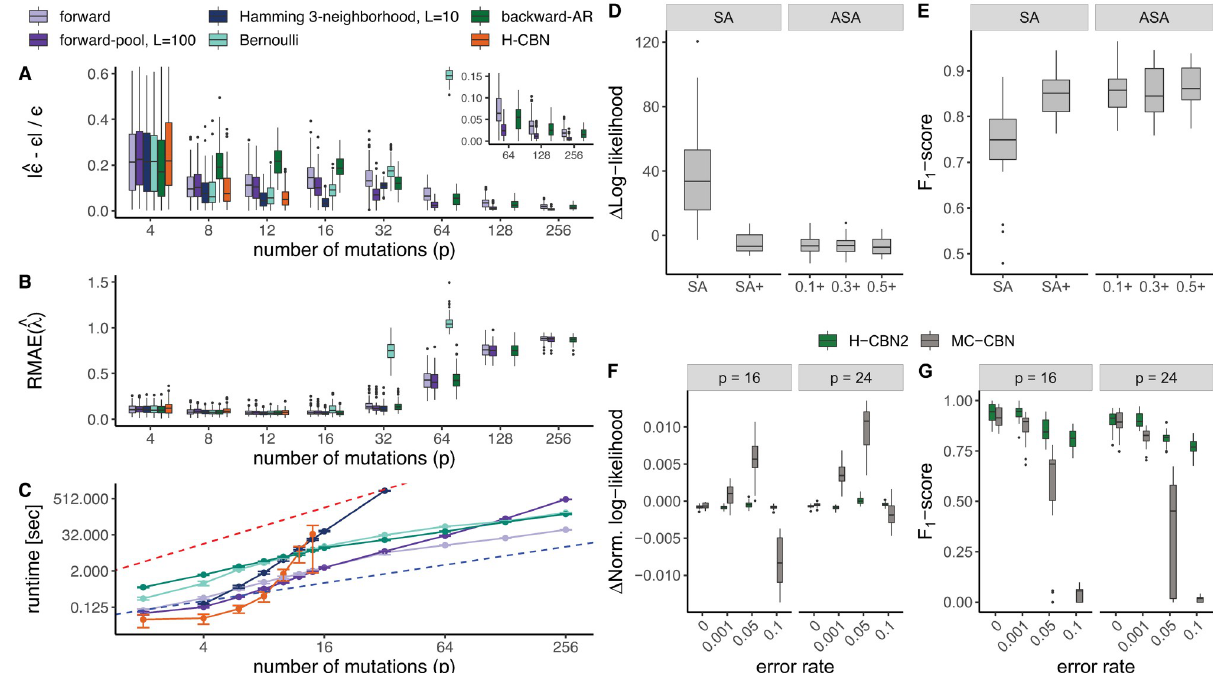
Fig 2. Assessment of H-CBN2 on simulated data. A Box plots of the difference between true ( � ) and estimated ( ^ � ) error rate (y-axis) for each of the evaluated poset sizes (x-axis). B Box plots of the relative median absolute error (RMAE; y-axis) of the estimated rate parameters ^ l . C Average run time of the MCEM/EM step (y-axis, logarithmic scale) for different poset sizes (x-axis, logarithmic scale). The blue dotted line corresponds to linear scaling, whereas the red line corresponds to quadratic scaling. In panels A to C, different colors indicate different importance sampling schemes and we show results of 100 simulated data sets for each of combination of the simulation settings. The true error rate is � = 0.05, the number of samples drawn from the proposal distribution is set to L = 1000 unless specified otherwise and we run 100 iterations of the MCEM/EM algorithm. D Error in the estimation of the log-likelihood, ‘ ð l ;�; P Þ (cid:0) ‘ ð ^ l ; ^ �; ^ P Þ . E Box plots of F 1 scores for reconstructed network edges. In panels D and E, we show results of 20 different networks with 16 mutations and an error rate of 5%. We fix the ideal acceptance rate to 1/ p , and run 25,000 iterations of the simulated annealing algorithm. The initial temperature is set to Θ 0 = 50 for all runs, and for adaptive simulated annealing, three adaptation rates are evaluated ( a 0.5). Comparison of H-CBN2 to MC-CBN methods in terms of F the difference in normalized log-likelihood and G F 1 scores for two poset sizes and various error rates. For the H-CBN2 results shown in panels F and G, we employ the ASA algorithm. SA: simulated annealing, ASA: adaptive simulated annealing, +: with additional new moves.